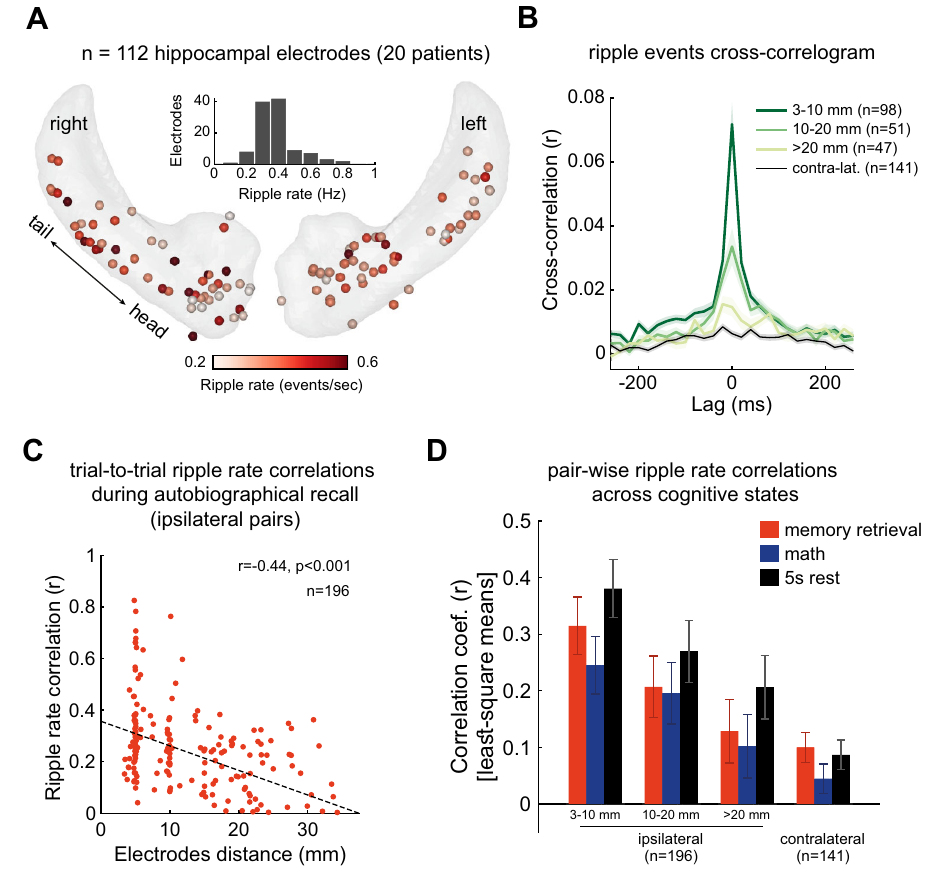
Fig. 3 | Trial-to-trial SPW-R rate correlations within and across the hemi- spheres. A SPW-R rates computed throughout the entire task (20 patients). Inset: distributionofSPW-Rratesacrosselectrodes. B CoincidentactivationofSPW-Rsas a function of electrode (0.86mm in diameter) distance (intercontact